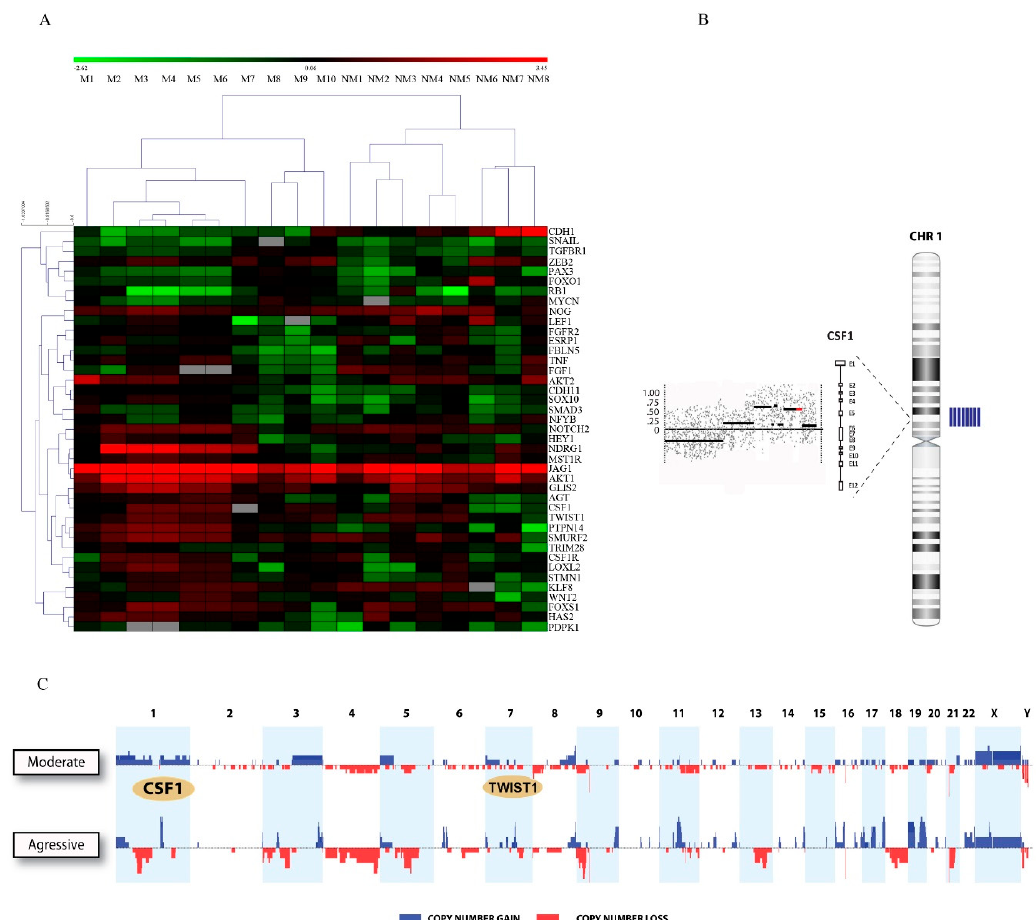
Figure 1. TWIST1 and CSF1 were clustered within the gained/amplified chromosomal regions in patients with highly metastatic oral cancer. ( A ) OSCC were sorted using hierarchical unsupervised clustering based on genomic data of EMT genes according to clinical information (M: metastatic vs. NM: non-metastatic OSCC). ( B ) Representation of the chromosome 1 showing the DNA amplification for csf1 sequence in patients with metastatic disease (blue bars in the right of the image). ( C ) The frequency plot identified a large number of chromosomal imbalances in more than 90% of aggressive/metastatic OSCC compared with non-metastatic tumors. The highest scoring locus identified in this analysis were 1p13.3 and 7p13 corresponding to CSF1 and TWIST1 .